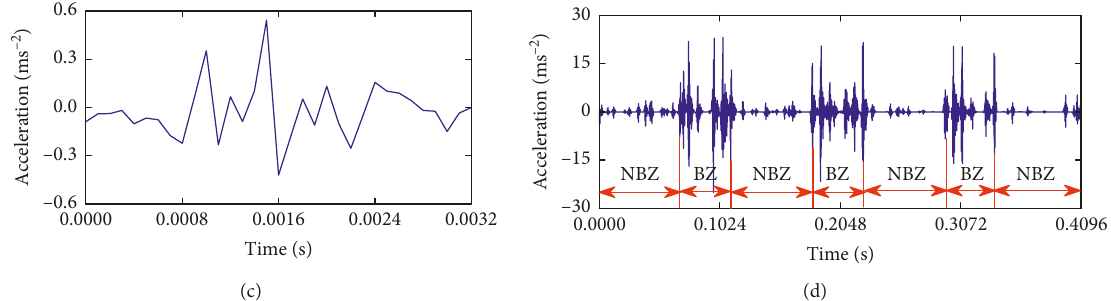
Figure 35: Learned impulse responses: (a) IR1; (b) IRS1 of IR1; (c) IR2; (d) IRS2 of IR2.